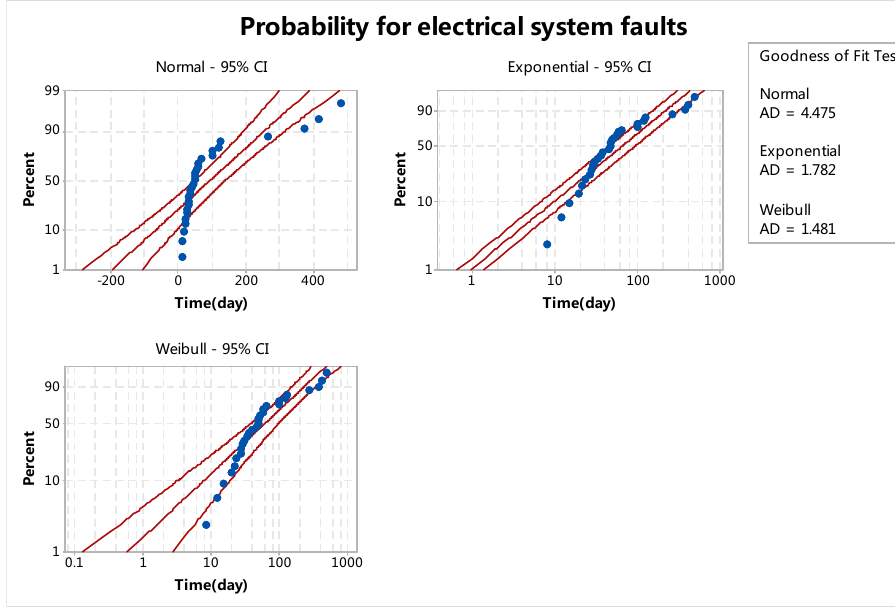
Figure 14. Goodness of fit test for electrical system faults.